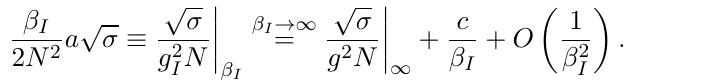
Figure 20 . E(cid:11)ective energies of (cid:13)ux tubes of approximately the same physical length, l in SO(5) at (cid:12) = 17 : 5 ; 20 : 0 ; 23 : 5 ; 27 : 5 ; 32 : 0 ; 36 : 0 as a function of n t = t=a . Lines represent our energy